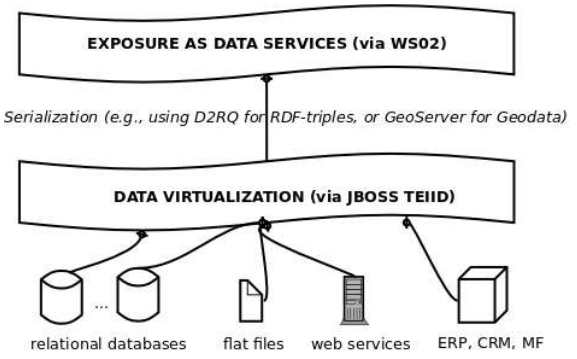
Figure 1: Schema of the Open-DAI